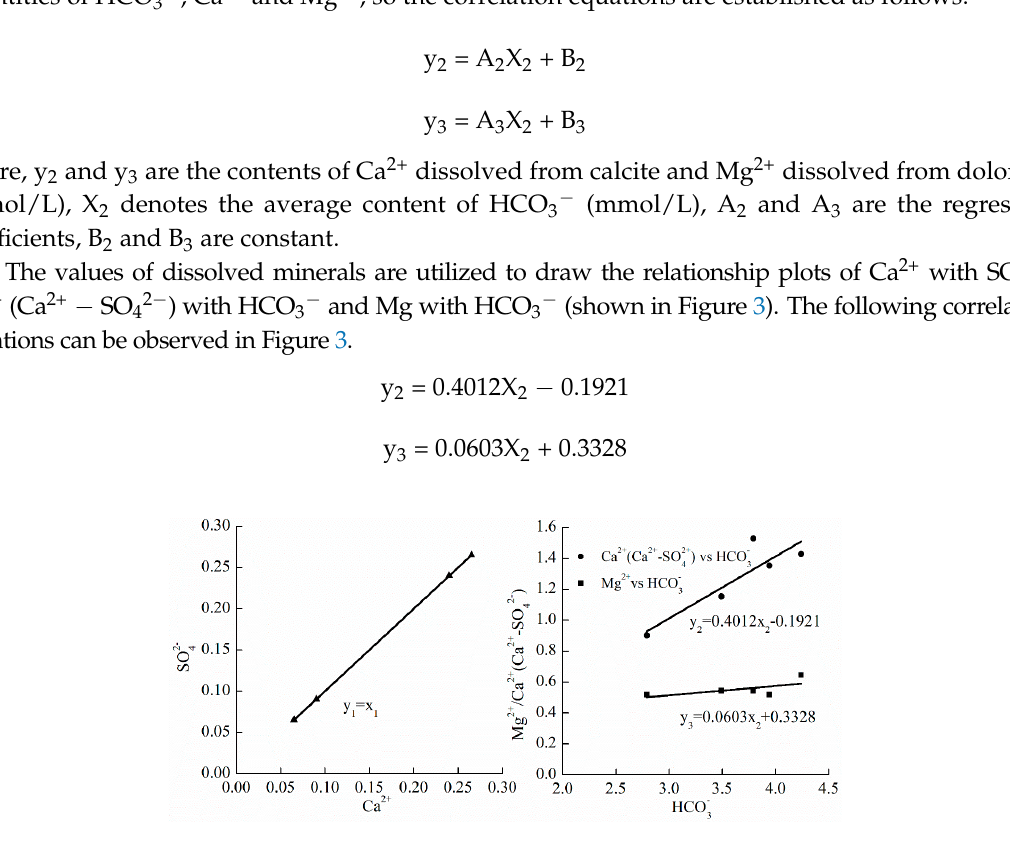
Figure 3. The relationship plots of Ca 2+ vs. SO 42 − and Ca 2+ (Ca 2+ − SO 42 − ) vs. HCO 3 − , and Mg 2+ vs. HCO 3 − . Figure 3. TherelationshipplotsofCa 2+ vs. SO 4 2 − andCa 2+ (Ca 2+ − SO 4 2 − )vs.HCO 3 − ,andMg 2+ vs.HCO 3 −